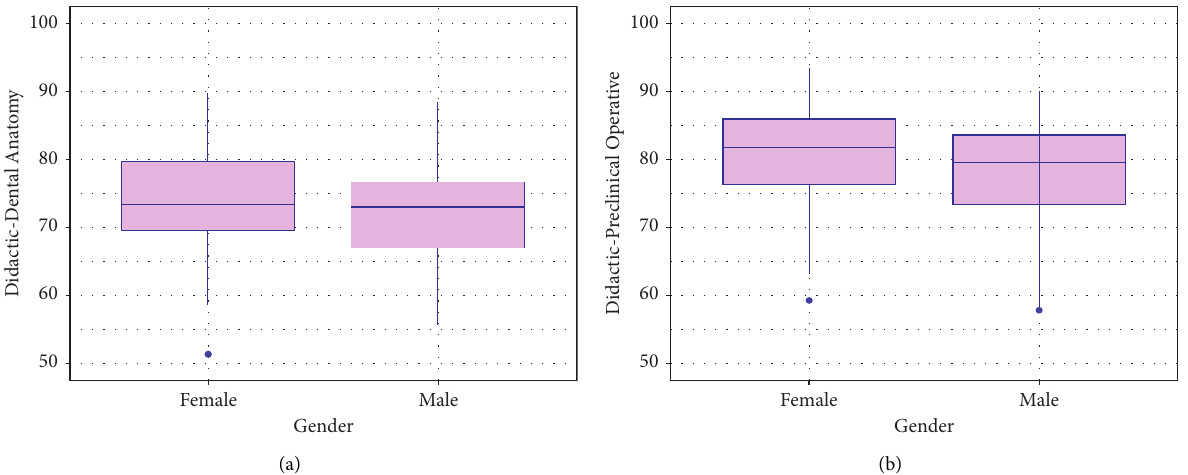
Figure 1: Box plots of the dental anatomy and preclinical operative dentistry courses didactic scores for male and female students. (a) Dental anatomy didactic scores for male and female students. (b) Preclinical operative dentistry didactic scores for male and female students.